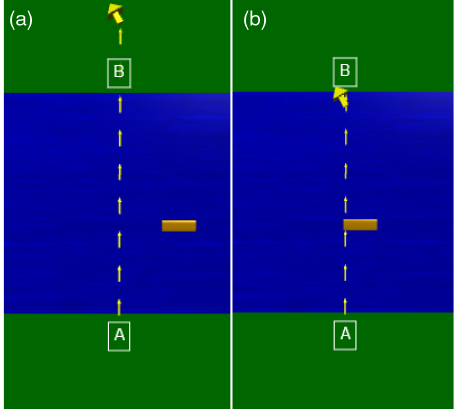
FIG. 4. Computational model of a boat crossing a river. The large yellow arrow represents the boat, the smaller yellow arrows represent a motion map of the boat ’ s velocity at different time instances, and the dark brown rectangle represents a log floating in the river (i.e., only affected by the current). Panel (a) displays the boat incorrectly continuing after it reaches the opposite shoreline, and panel (b) displays the boat correctly stopping when it reaches the opposite